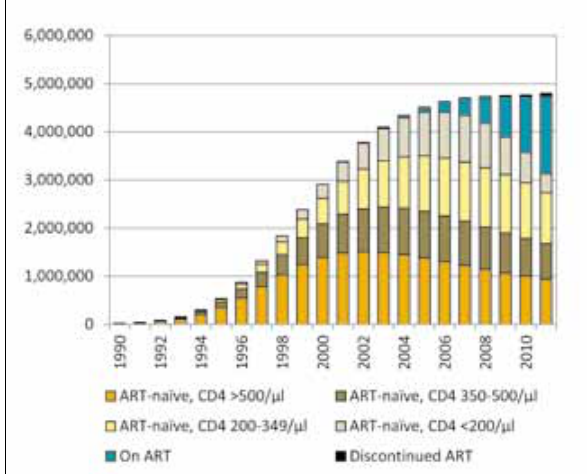
Fig. 2. Numbers of HIV-positive adults, by CD4 count and ART status. Numbers exclude paediatric HIV infections. Bars represent posterior means (95% confidence intervals not shown).